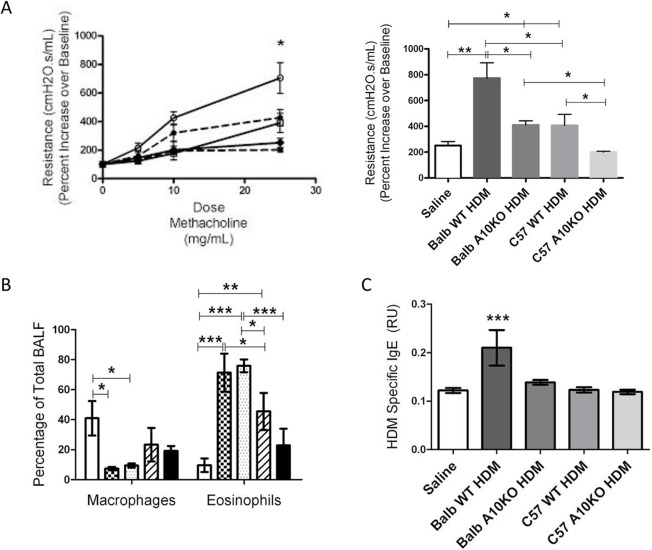
B-ADAM10 deletion attenuates bronchoconstriction and HDM specific IgE.(A) Airway resistance (cmH20.s/mL) with increasing doses of methacholine (left); Balb-WT (──,○), Balb-ADAM10B-/-(——,●), C57-WT (──,□), C57-ADAM10B-/- (——,○), Saline (──,●) presented as fold increase from saline control. Bar graph (right) represents 25 mg/mL methacholine dose. (B) Percent macrophages (left) and eosinophils (right) from total BALF determined by flow cytometry; Saline control (white), Balb WT (checkered), Balb-ADAM10B-/- (dotted), C57 WT (slash), and C57-ADAM10B-/- (black). (C) HDM specific IgE production. n = 7–9 per group, 3 independent experiments. All mice immunized with saline demonstrated comparable results. For simplicity, saline represents Balb WT mice given saline. *p<0.05, **p<0.005, ***p<0.005.